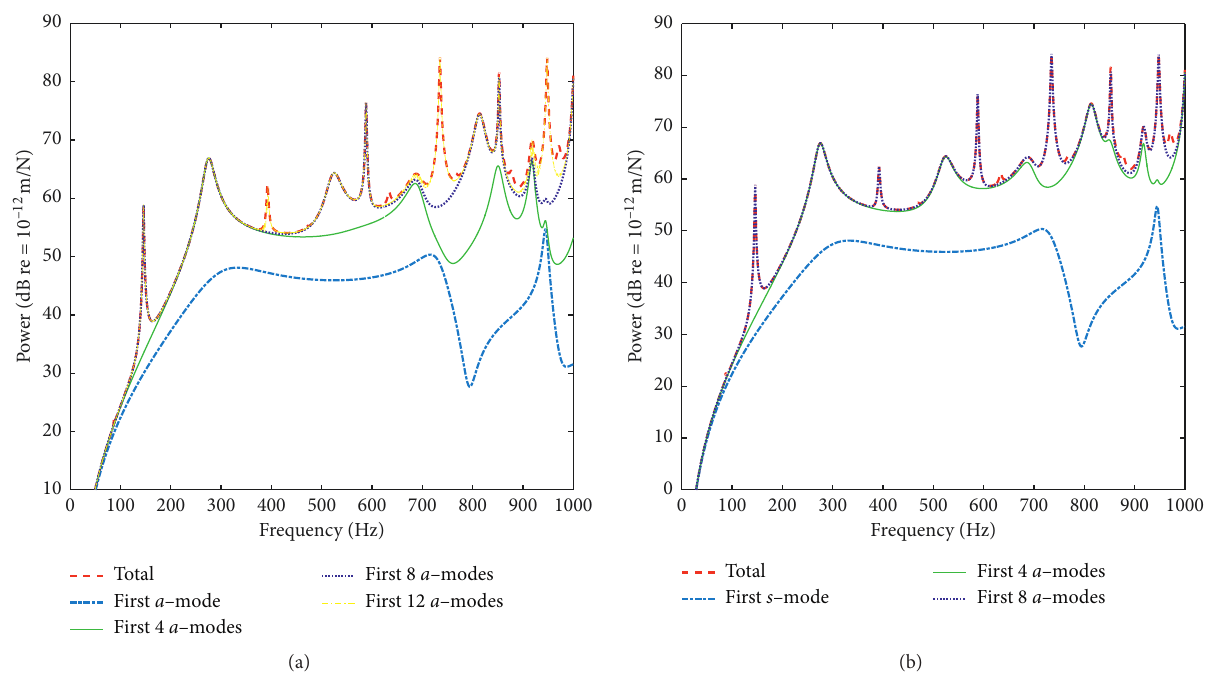
Figure 4: Radiated sound power from the first several a -modes and s -modes. (a) a -modes; (b) s